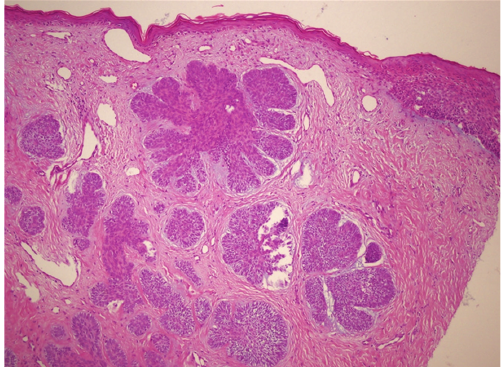
Figure 2: Basal cell carcinoma. Small islands of basaloid cells with peripheral palisading, showing connections with the overlying epidermis